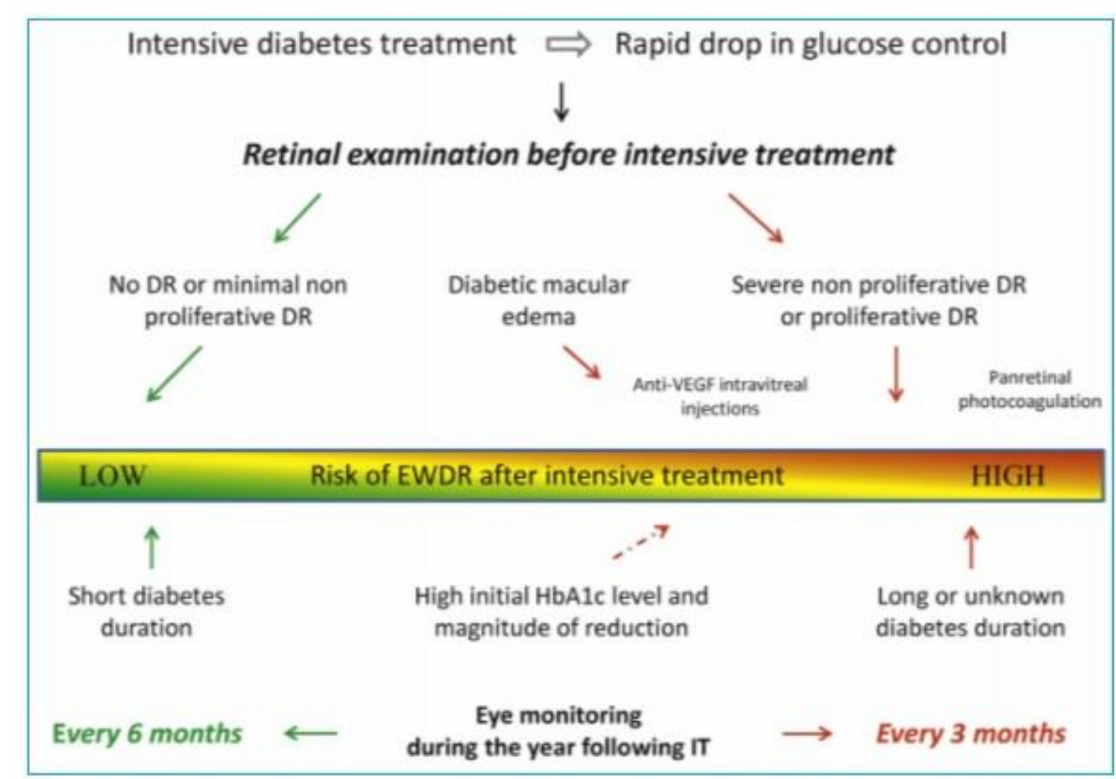
Figure 2. Eye monitoring and treatment algorithm associated with intensive diabetes treatment. DR: diabetic retinopathy; EWDR: early worsening diabetic retinopathy; VEGF: vascular endothelial growth factor; IT: intensive treatment